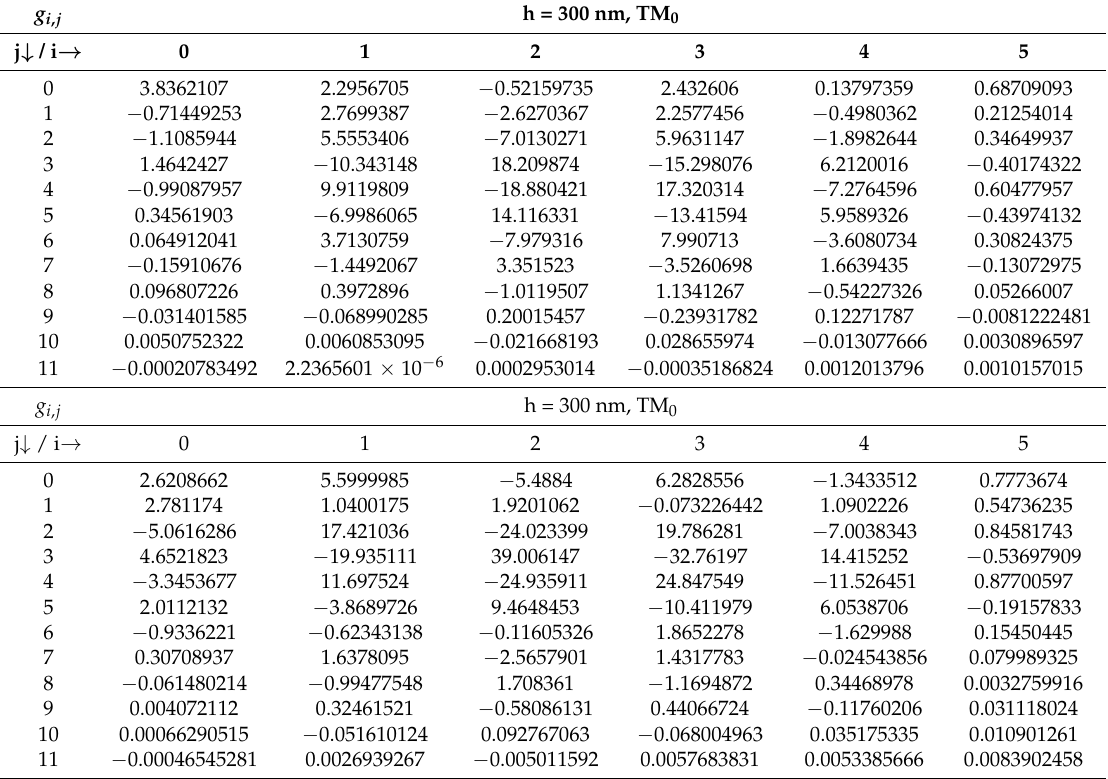
Table A3. γ core Bézier curve coefficients for h = 300